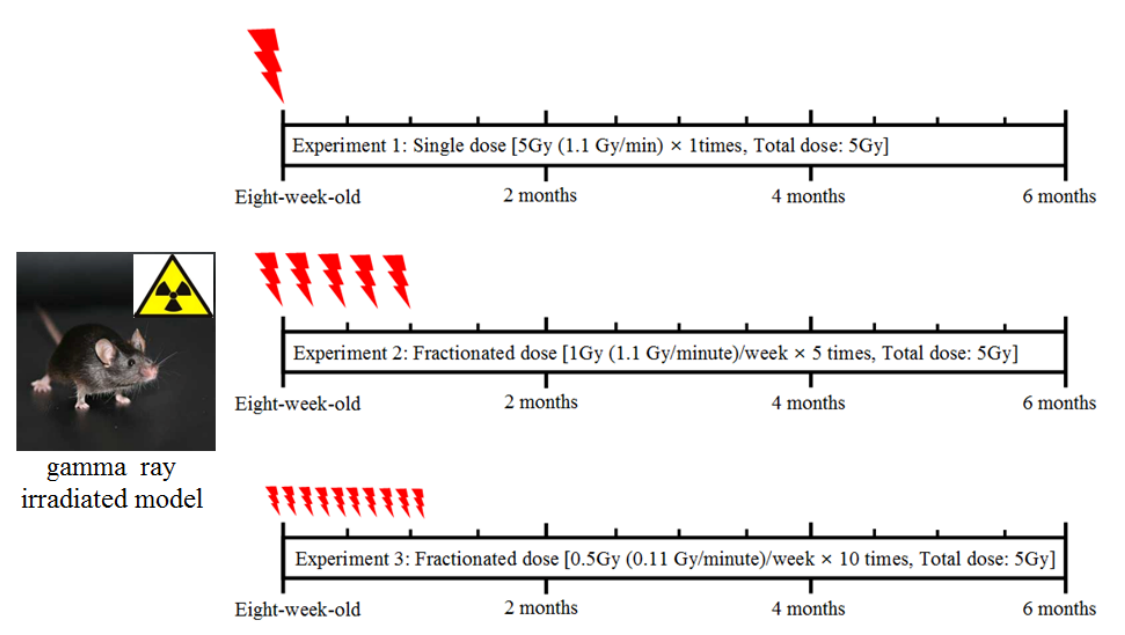
Figure 1. Gamma-ray irradiated models by acute or fractionated whole-body